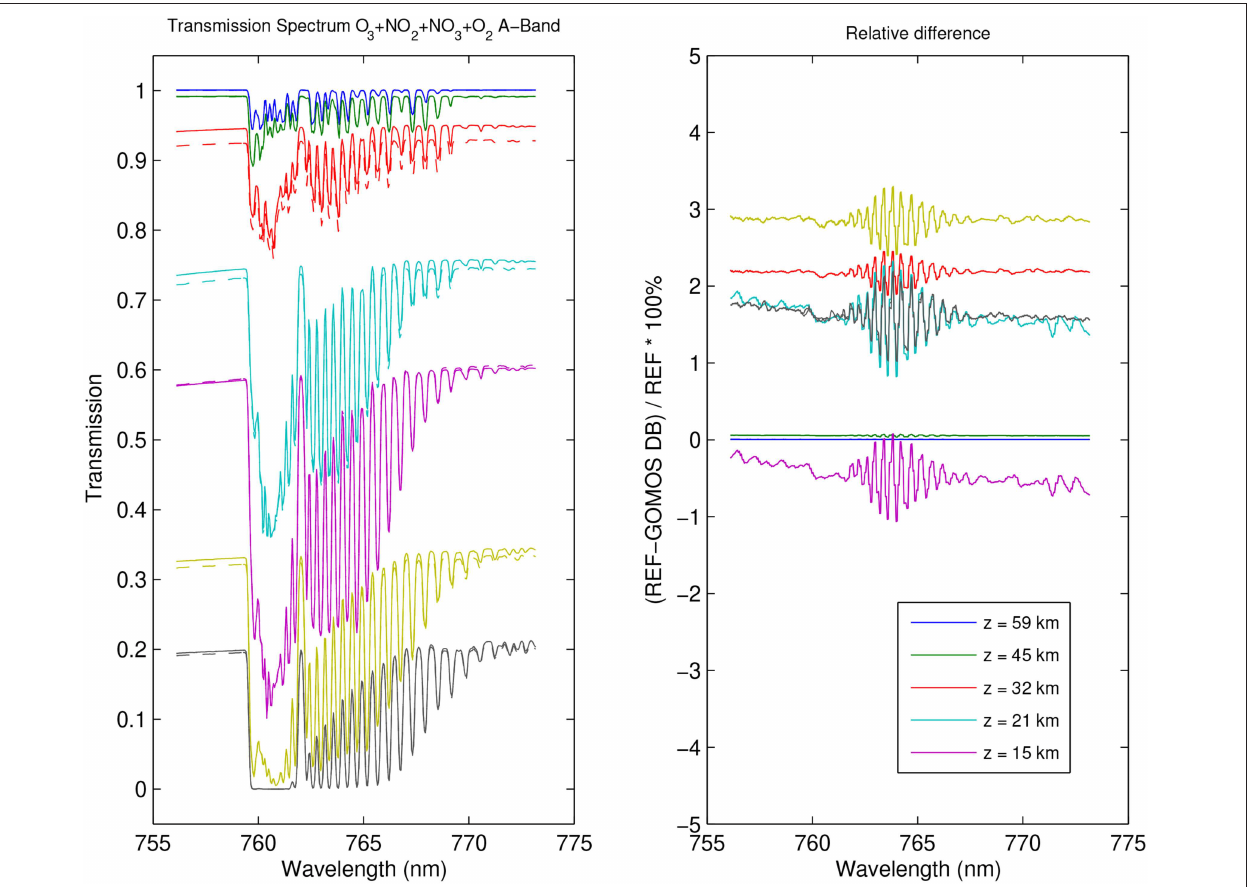
FIGURE 11 | Same as Figure 10 , for a spectral range corresponding to the GOMOS spectrometer SPB1. The O 2 A-band contribution has been taken into